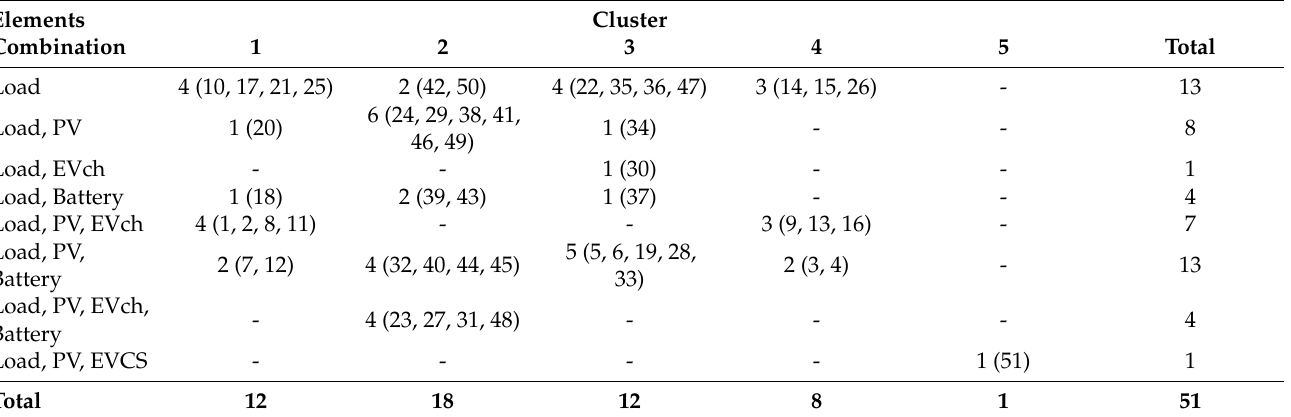
Table 4. Number of users involved at each cluster with their elements combination. In brackets the User ID is